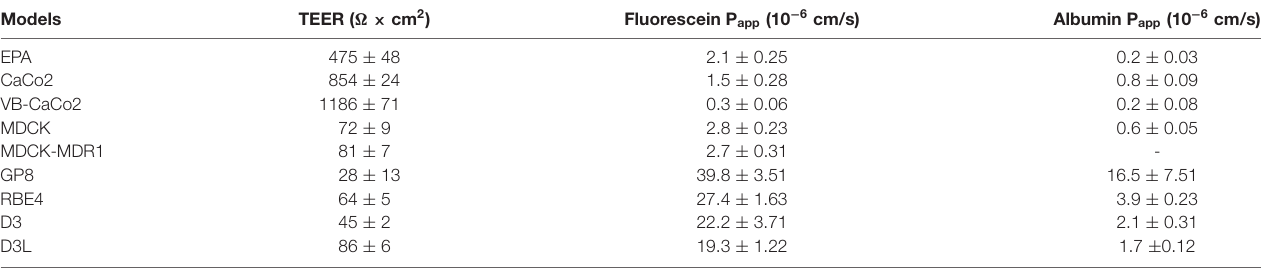
TABLE 1 | Paracellular tightness of different brain endothelial and epithelial cell culture models measured by transendothelial/epithelial electrical resistance (TEER) and permeability for markers fluorescein and albumin.